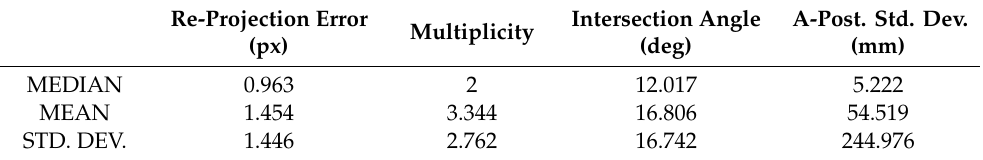
Table 4. Median, mean and standard deviation values for the quality features computed on the original (not filtered) sparse point cloud (~405,000 3D tie points).